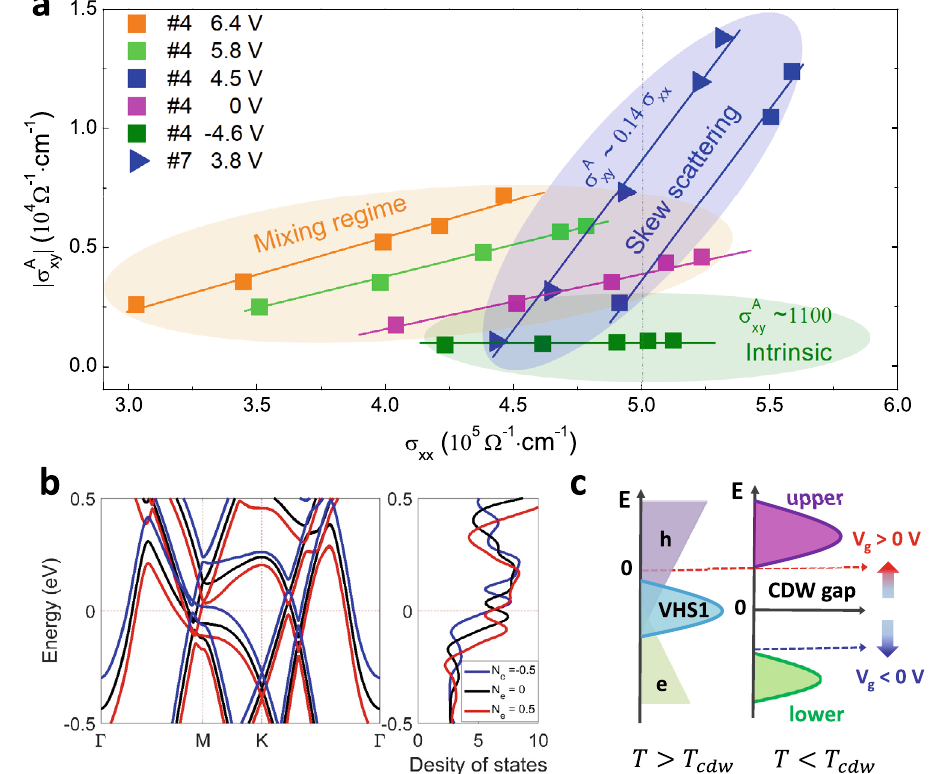
c Illustration of the evolution of Fermi energy under different gate voltages. Red dashed arrow shows the probable Fermi level in bulk crystal (slightly above VHS1). Cs vacancies in CsV 3 Sb 5 nano fl akes will signi fi cantly lower the Fermi level (black arrow). Applying a negative (positive) voltage will shift the Fermi level downward (upward). The giant AHE occurs when the Fermi level approaches the upper sub- band with relatively large